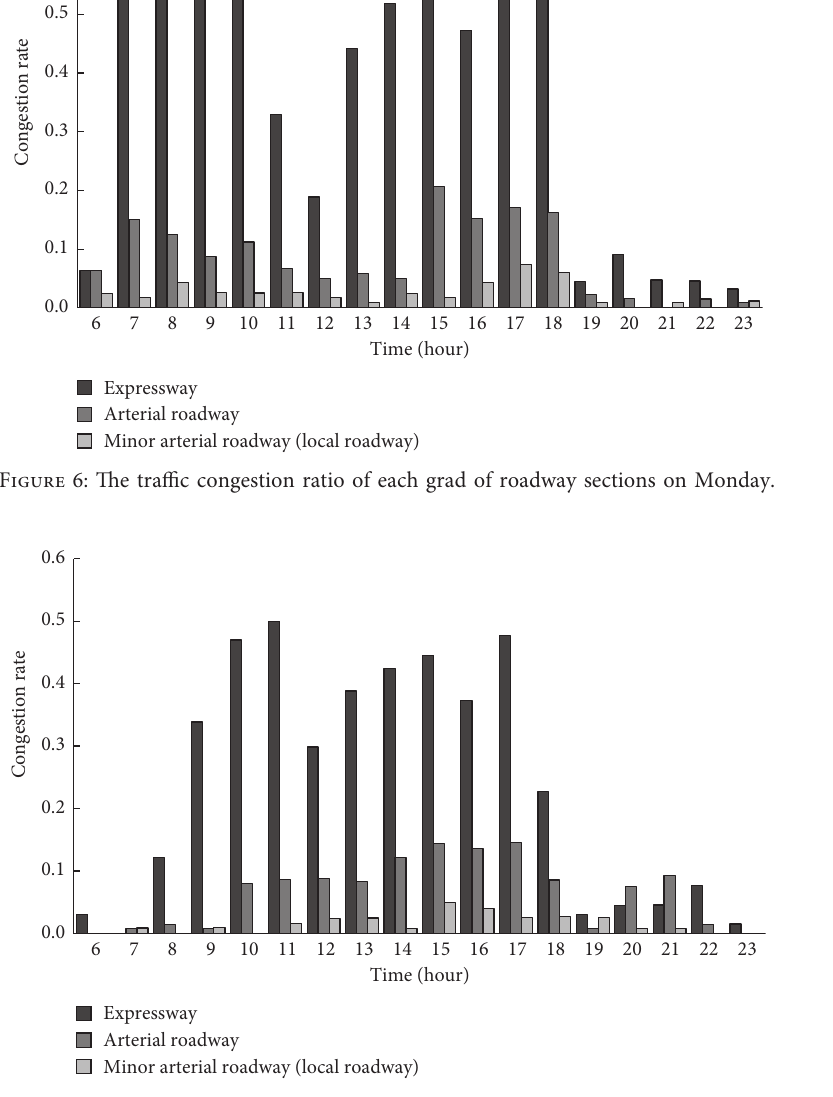
Figure 7: The traffic congestion ratio of each grad of roadway sections on Saturday.